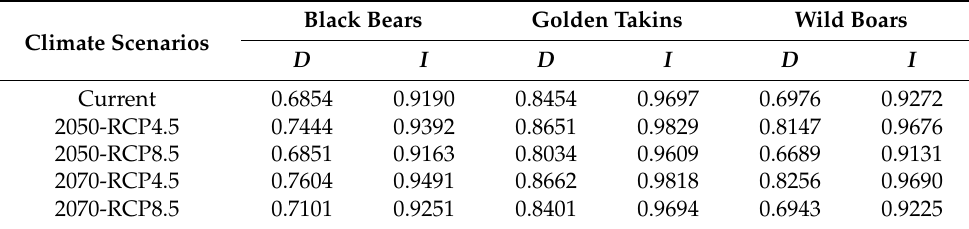
Table 3. Niche similarity between giant pandas and sympatric competitive species under different